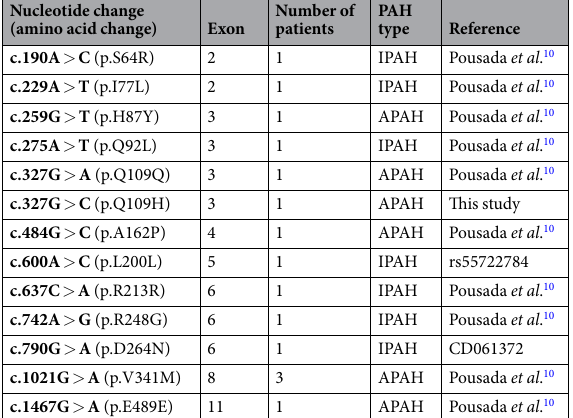
Nucleotide change Region Score (1) Effect on protein